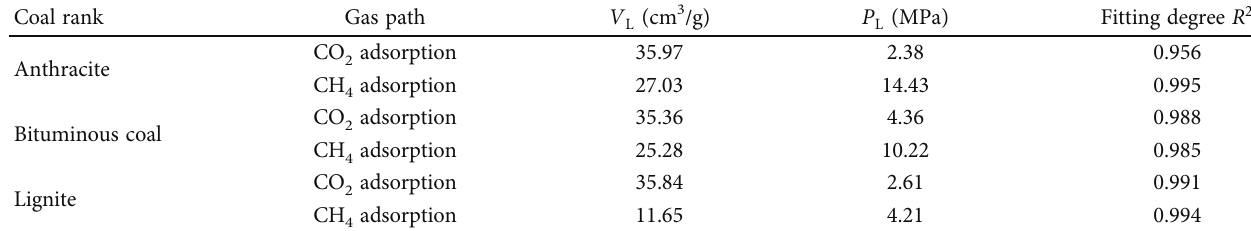
Figure 3: Langmuir curves of three coal samples. Table 2: Langmuir parameters of di ff erent rank coal